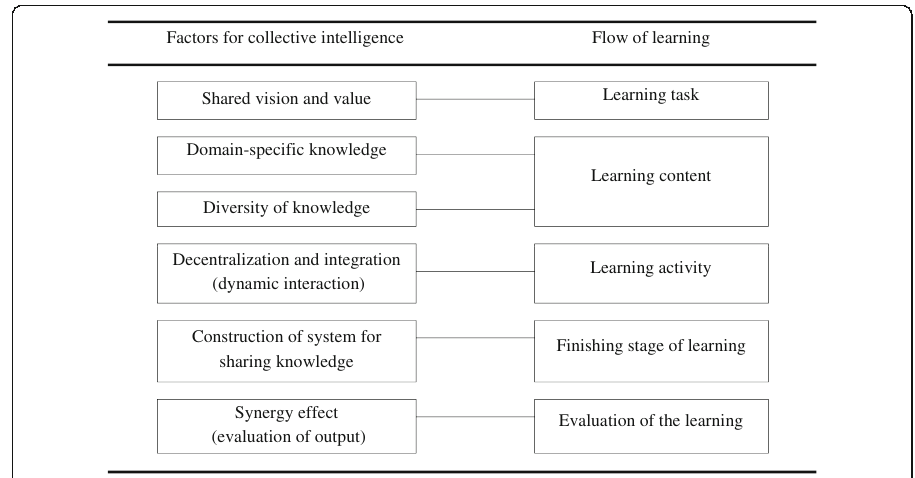
Fig. 1 The relationship between the factors for collective intelligence and the learning process